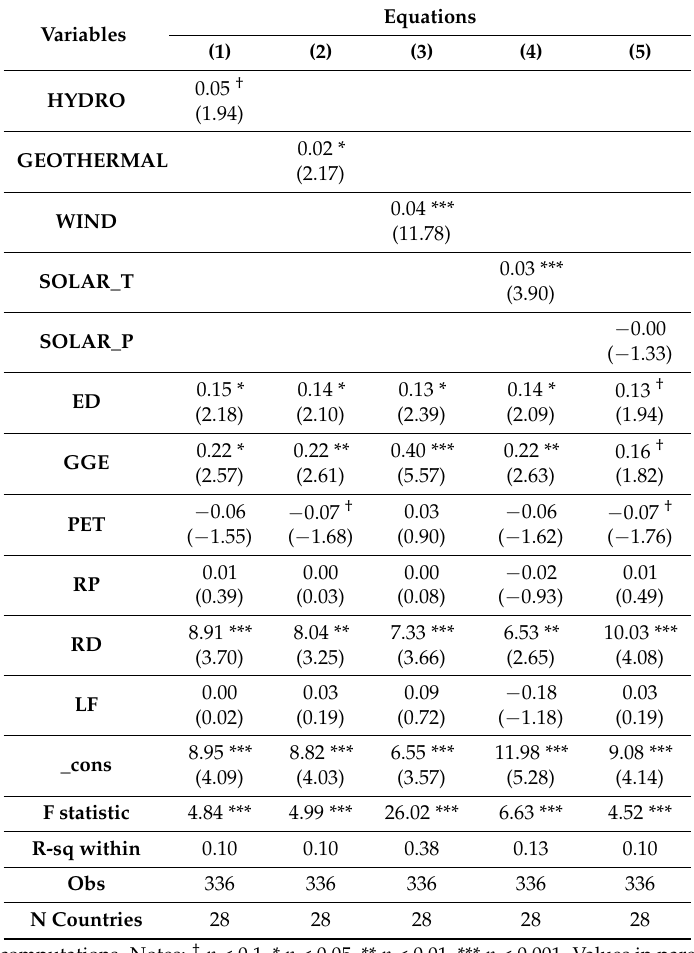
Table 8. Fixed-effects estimations towards the effect of hydropower, geothermal energy, wind, and solar energy on sustainable economic